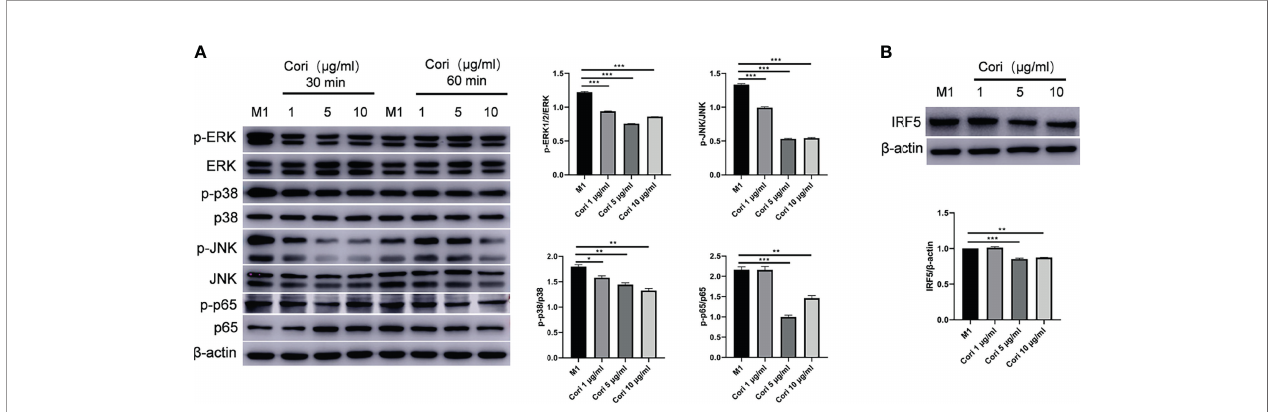
FIGURE 6 | Corilagin inhibits M1 macrophage activation by inhibiting the MAPK, NF- k B and IRF signaling pathways. BMDMs were treated with corilagin (1, 5, or 10 m g/ml) for 2 h, followed by stimulation of LPS and IFN- g . After 30 and 60 min, cells were collected for the detection of MAPK and NF- k B signaling pathway-related molecules. Finally, 24 h later the cells were collected for the detection of IRF5. (A) Western blot analysis and statistics of the phosphorylation levels of JNK, ERK, p38, and NF- k B p65. (B) Western blot analysis and statistics for IRF5. *p < 0.05, **p < 0.01, ***p < 0.001.